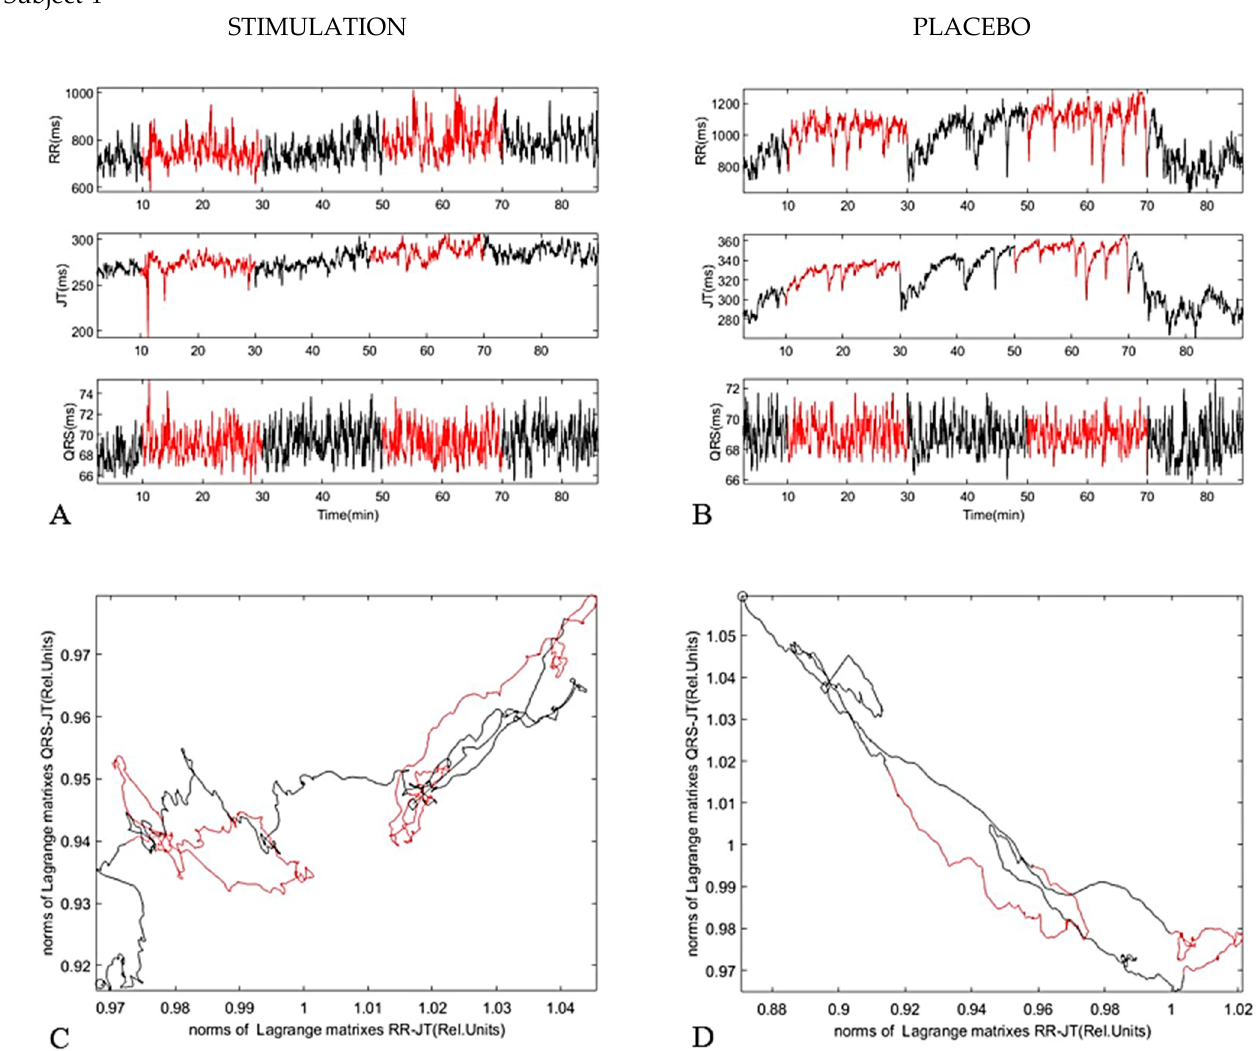
Figure 8. Subject 4. ( A ) dynamic of parameters RR interval, JT interval, and QRS duration during investigation (Stimulation). ( B ) dynamic of parameters RR interval, JT interval, and QRS duration during investigation (Placebo). ( C ) phase plane for JT/QRS and RR/JT norms during stimulation. ( D ) phase plane for JT/QRS and RR/JT norms during placebo.